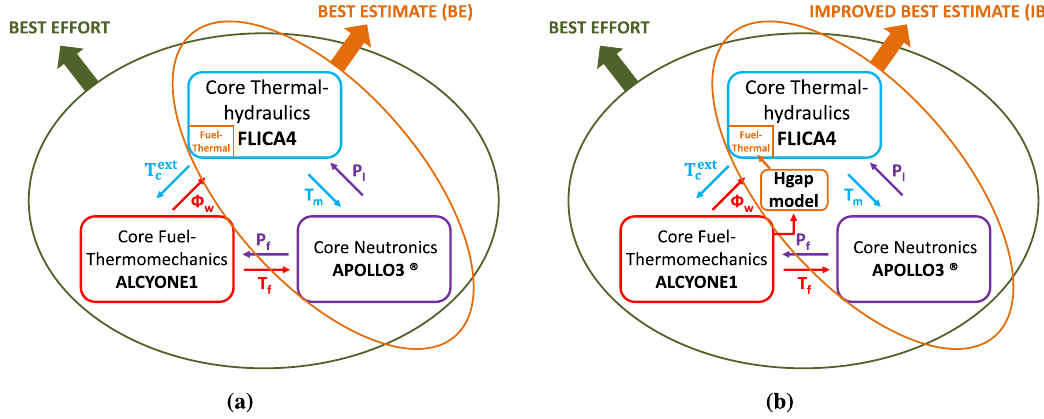
Fig. 1. CEA coupling framework used for REA (a) and the proposed improvement in the BE scheme (b).